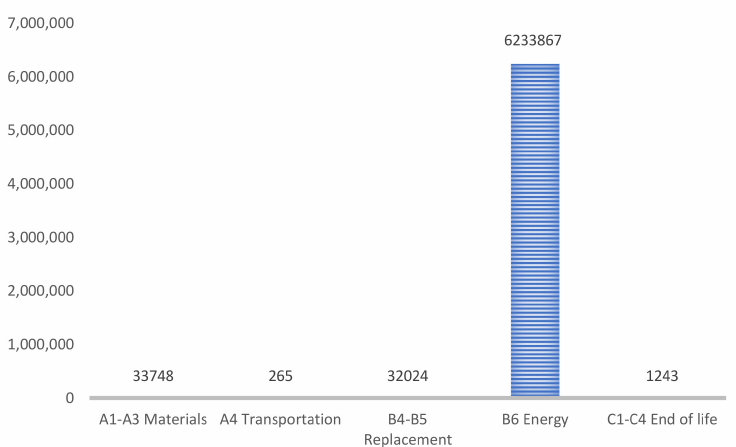
Figure 10. Scenario C: Global warming kg CO 2 , calculated considering the amount of operational